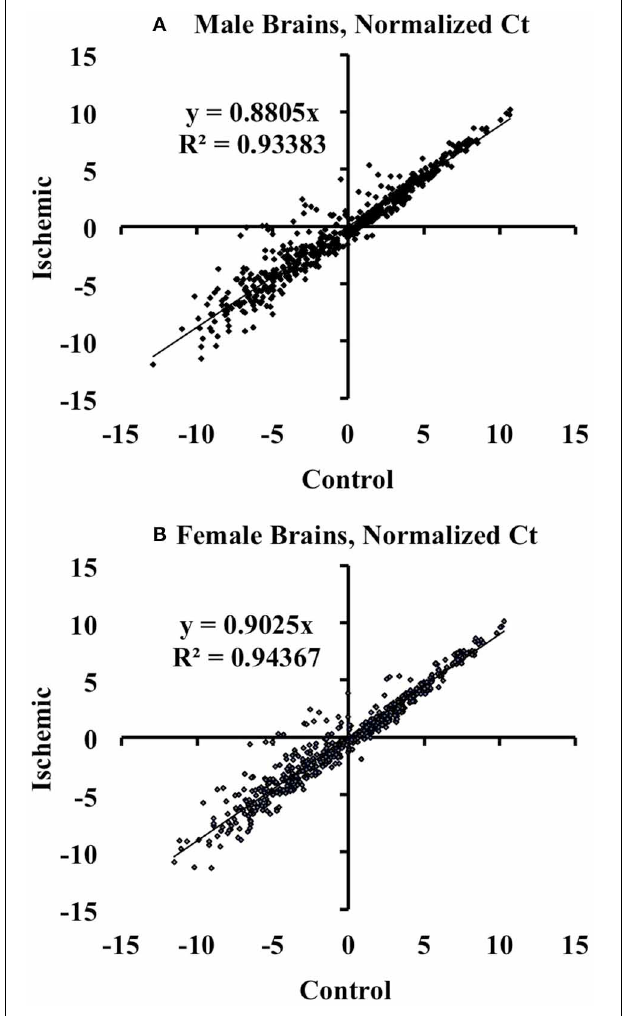
FIGURE 1 | Linear regression analysis of miRNAs altered by ischemia vs. control mouse cortices. The graphs illustrate that there are changes in miRNA expression in ischemia relative to control in male (A) and female (B) mouse cortex. The graphs also show that the majority of the assayed miRNAs are not altered by ischemia.